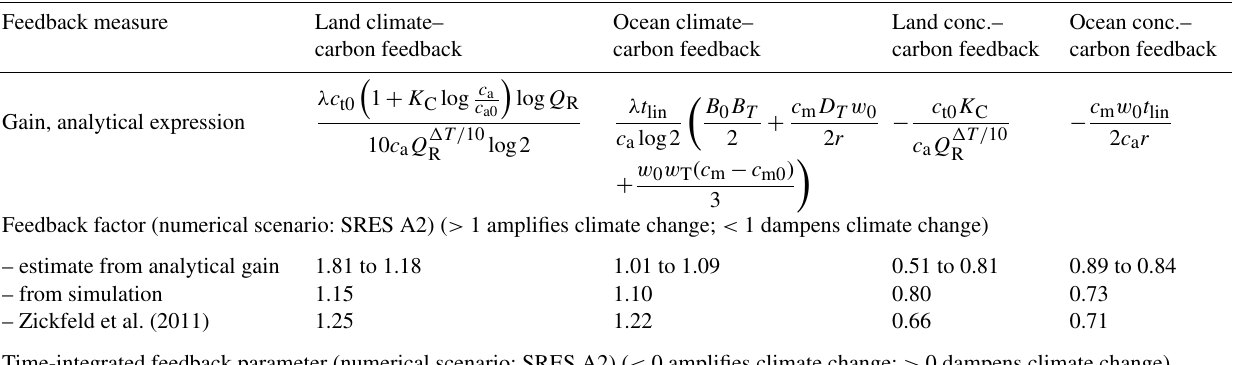
Table 3. Feedback analysis. Gains ( g ), feedback factors ( F ), time-integrated feedback parameters ( γ and β ), and direct feedback parameters ( (cid:48) and B ) were calculated analytically and numerically. Analytical ocean feedbacks are approximations of the exact forms in Table A1 (see Sect. 4.2). Exact forms were used to calculate numerical values. In this table, p ≡ p ( c m ,T ). Units of the climate–carbon integrated feedback parameters are PgC K − 1 and concentration–carbon integrated feedback parameters are PgCppm − 1 . Ranges for analytical results are written in the form (value at start of simulation) to (value at end of simulation). Emissions scenarios are as indicated; land use emissions were assumed to be zero. From the results of simulations using the SRES A2 scenario we use t lin ≈ 100 corresponding to a period between the years 2000 and